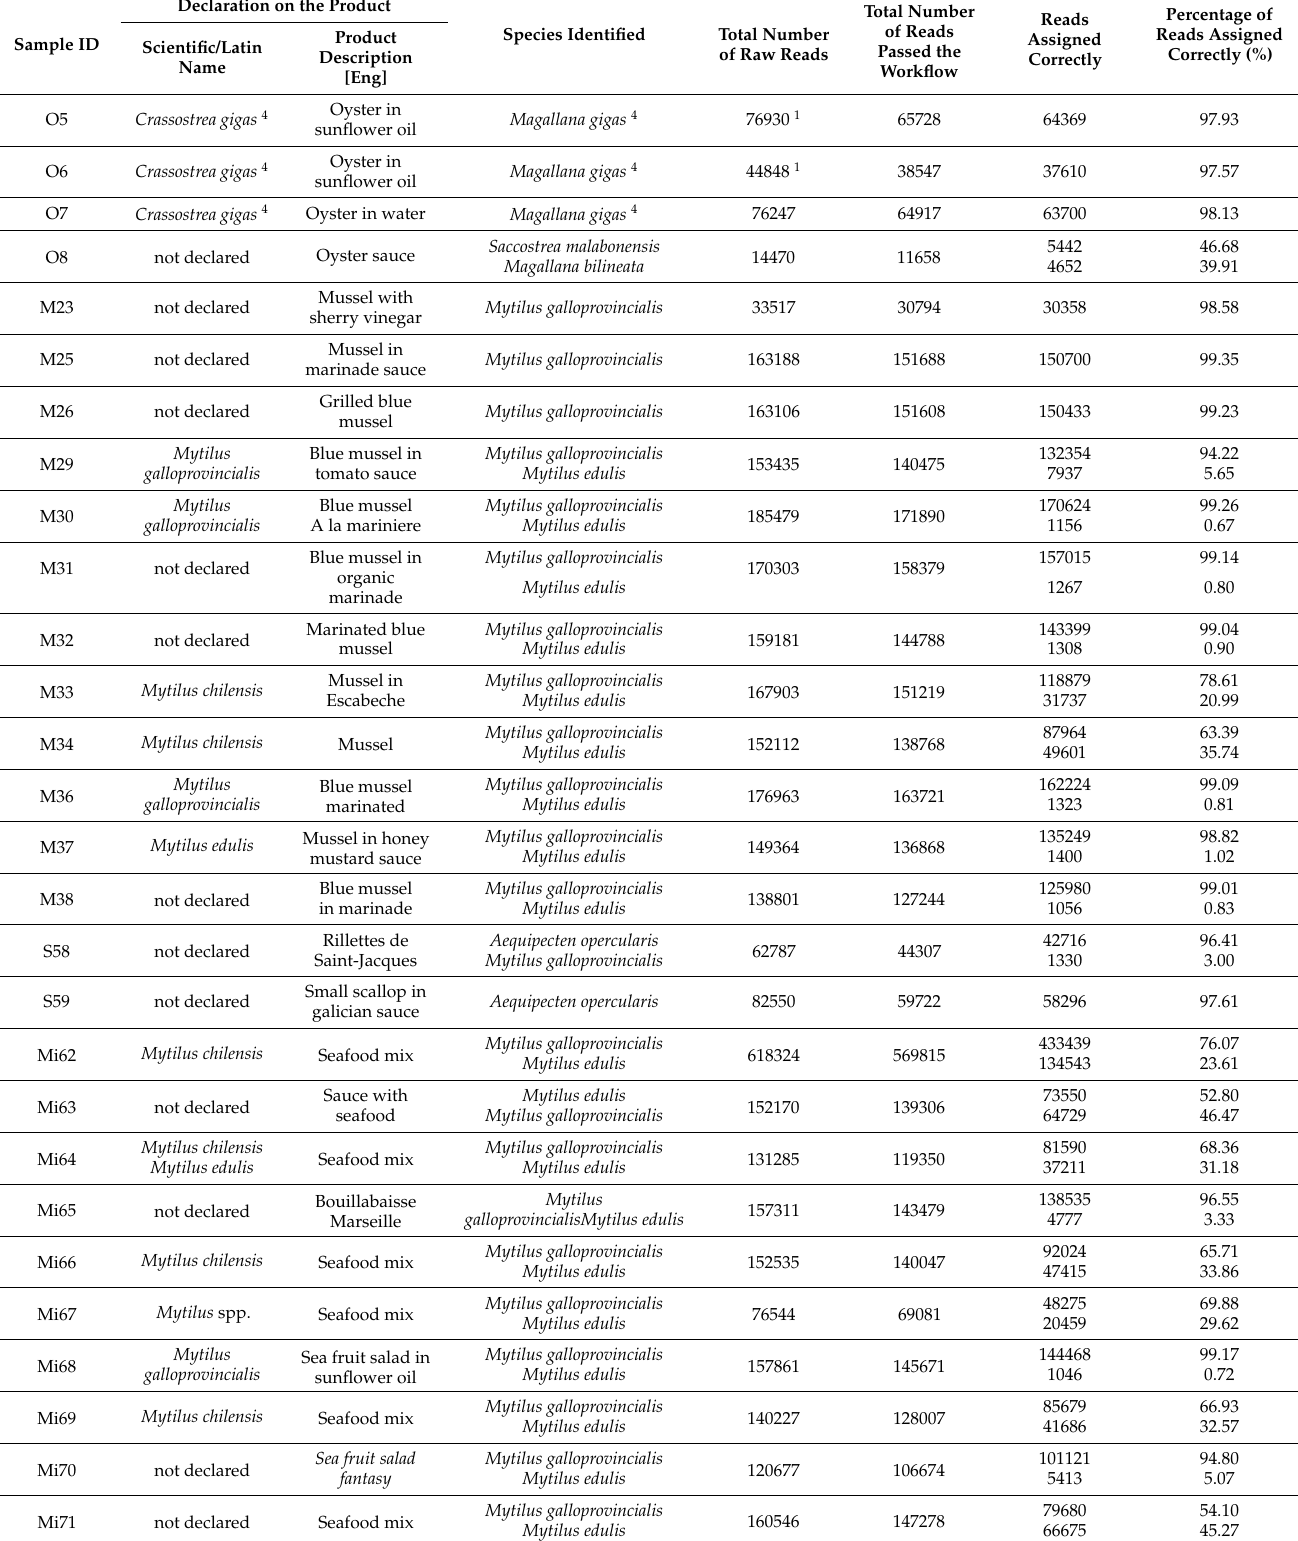
Table 6. Results obtained for commercial seafood samples. Samples listed above the double line were sequenced with the MiSeq ® (three sequencing runs, one replicate per run, numbers are mean values); samples listed below the double line were sequenced either with the MiSeq ® or the iSeq ®